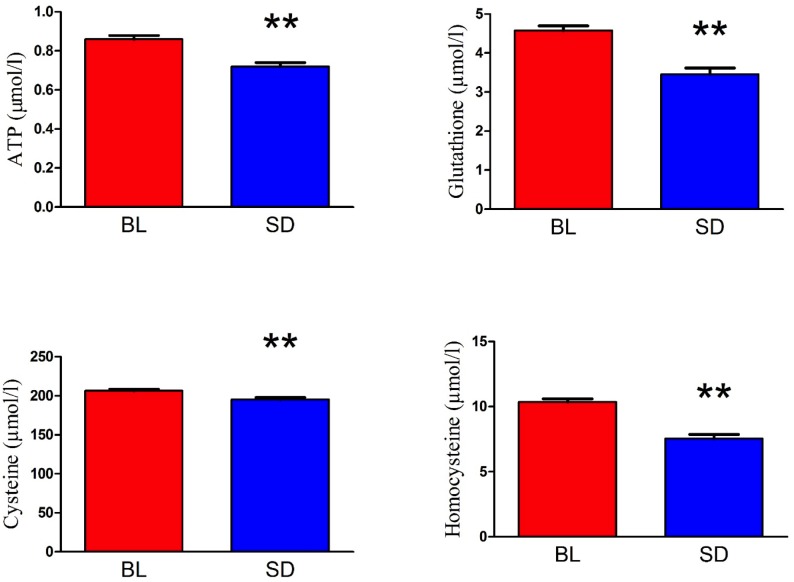
Thiol metabolite levels in plasma.Thiol / Thioether metabolite levels were analyzed via HPLC with electrochemical detection before (BL) and after sleep deprivation (SD) in participants (Mean +/- SEM). GSH / GSSG ratio indicates oxidative stress. HCY—homocysteine, Cys- cysteine were measured in uM. ATP measurement. ATP was measured using commercially available kit and expressed in umol/ L of plasma. Asterisk indicates a significant difference from baseline * = p < 0.05, ** = p < 0.01.